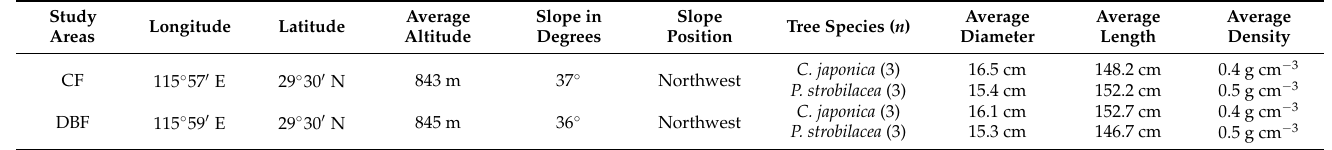
Table 1. General information (mean ± SE) of the CWDs of the two tree species at the two study areas in Lushan Mountain of subtropical China. CWD: Coarse woody debris; CF: Coniferous forest; DBF: Deciduous broad-leaved forest. Note: experiment material was all of similar decay stage.